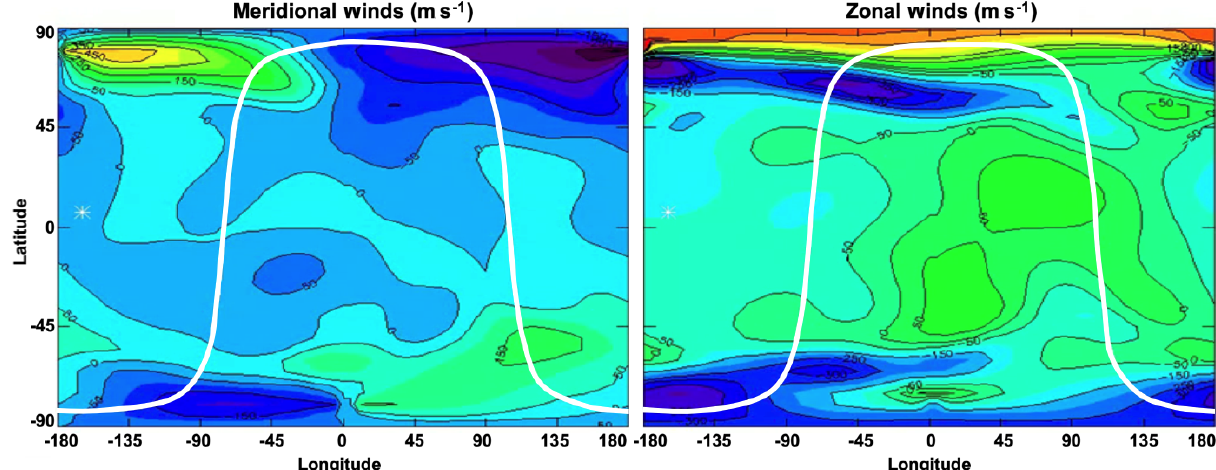
Figure 7. Simulations of meridional and zonal winds and the ground track of a spacecraft orbit. Values for winds are shown in the contours within each panel (ms − 1